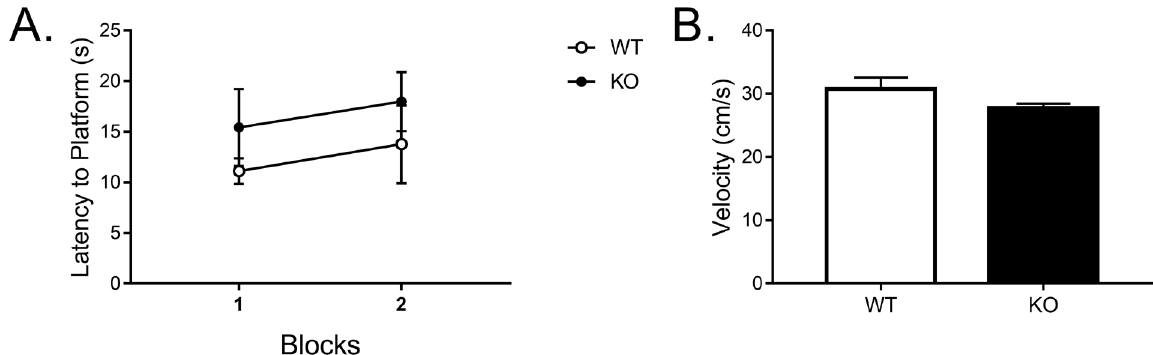
Figure 3. Performance in the Morris water maze visible trials. A . Fmr1 knockout males showed no deficits in latency to the platform across the two blocks of the visible platform test. B . Fmr1 knockout males showed no deficits in swim speed across the visible platform test. Knockout – KO, Wild type -